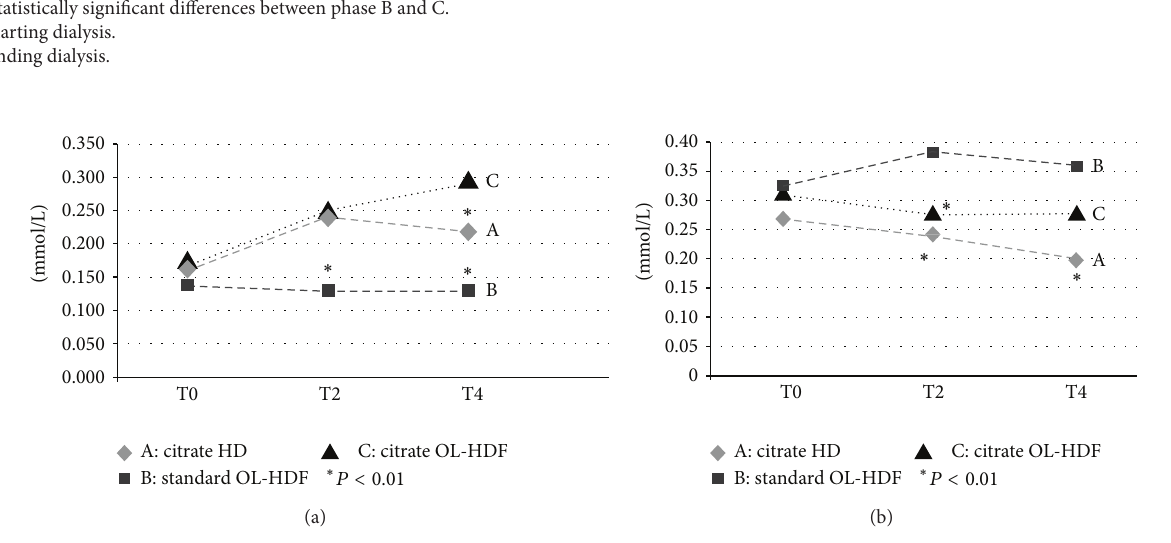
Figure 1: (a) Plasma levels of citrate during treatments. (b) Plasma levels of acetate during